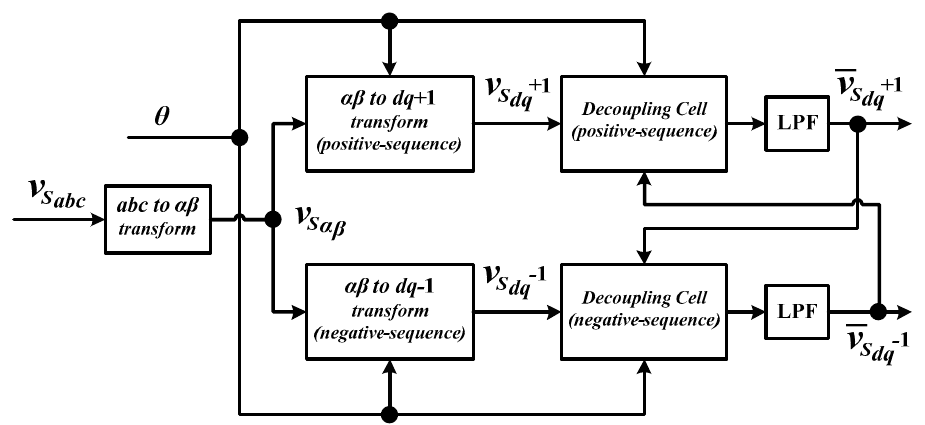
Figure 7. Block diagram of decoupling network in decoupled double SRF (DDSRF)-PLL [53].